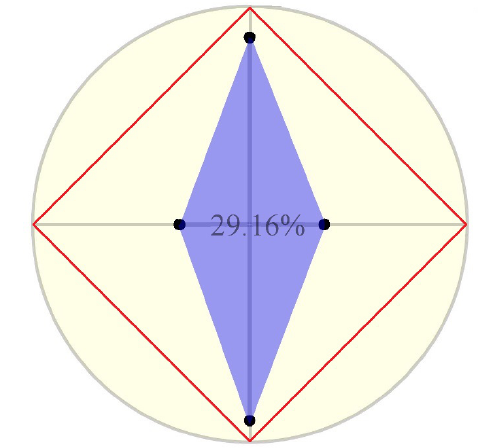
Figure 11. Calculating the grade of entity.